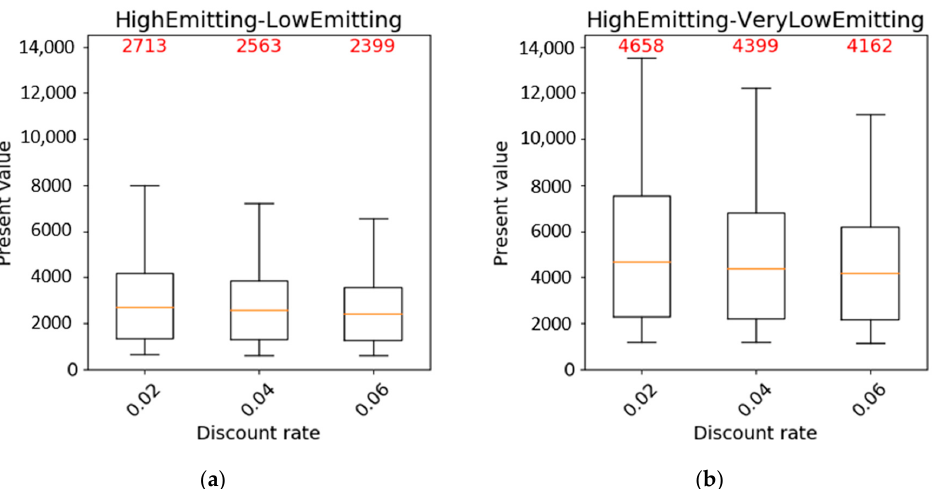
( b ) Figure 5. Present values calculated with different electricity prices. ( a ) Scenario HE − LE. ( b ) Scenario HE − VLE. The two remaining variable parameters to be analyzed are the discount rate and the number of